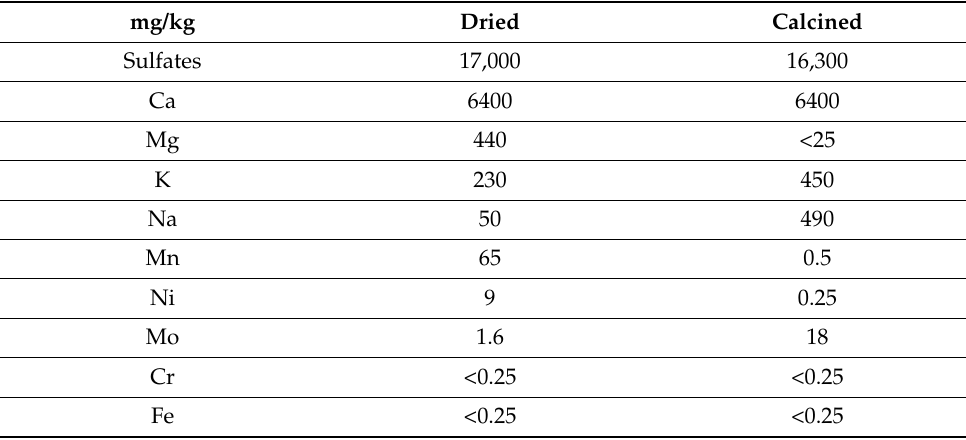
Table 6. Estimated concentration of the eluates obtained after water leaching.